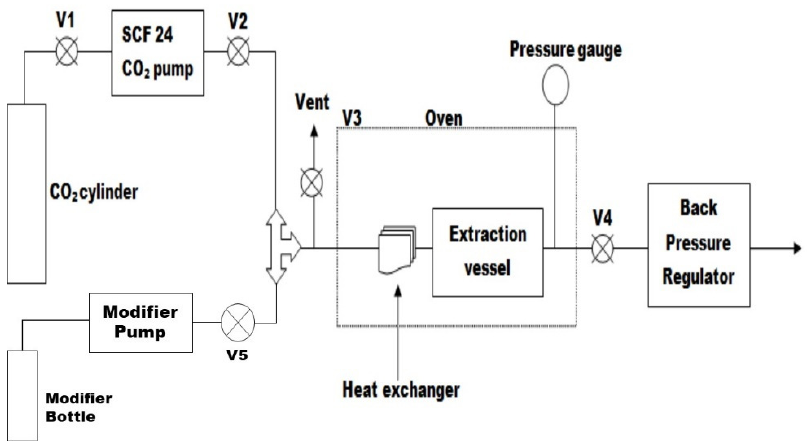
Figure 1. Schematic diagram of SCCO 2 extraction with modifier.